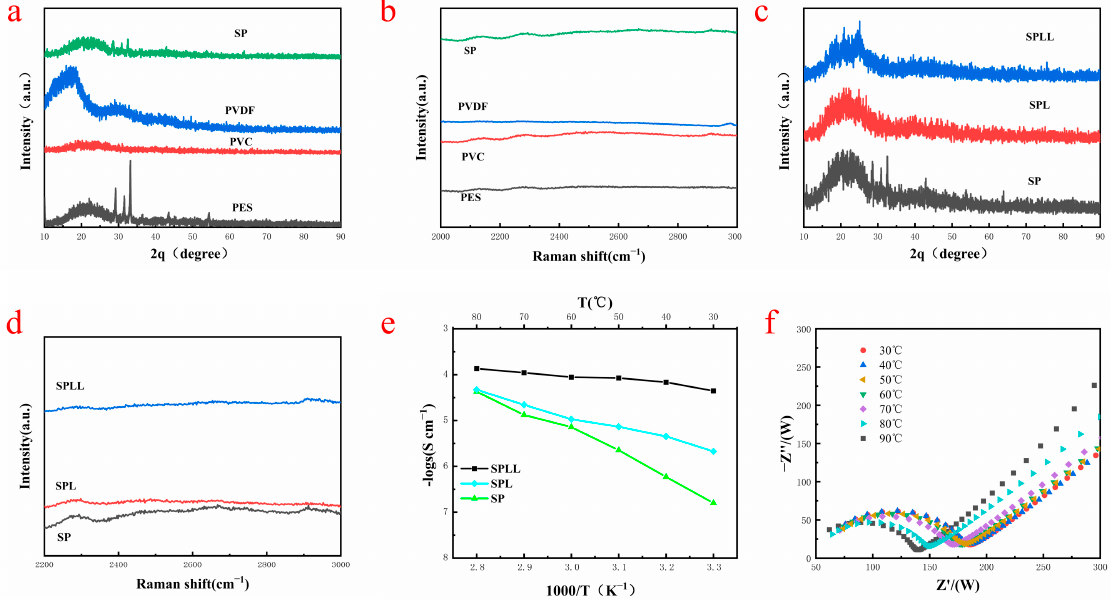
Figure 2. ( a , c ) XRD patterns of different polymer. ( b , d ) Raman patterns of different polymer. ( e ) Con- ductivity of polymer electrolyte at different temperatures. ( f ) SPLL impedance diagram at different temperatures.